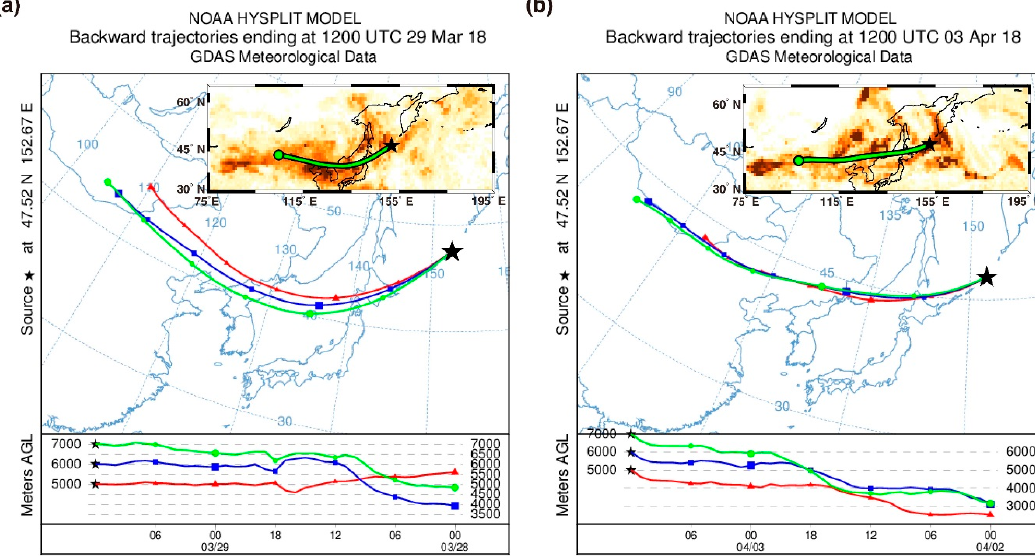
Figure 4. Back trajectories derived from the NOAA HYSPLIT model at different altitude levels (5000, 6000, 7000 m; red line, blue line, green line, respectively) at a point around the Kuril Islands (black star; 47.52° N, 152.67° E) on ( a ) 12:00 UTC 29 March 2018 and ( b ) 12:00 UTC 3 April 2018. The inset figures indicate the back trajectories at 7000 m overlaid onto Figure 3a and b, respectively.